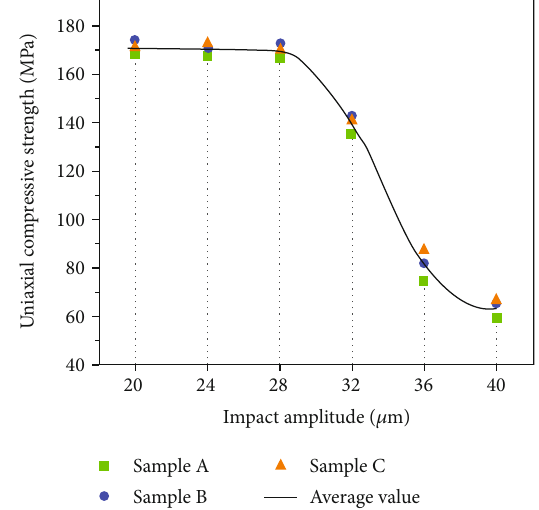
Figure 6: Uniaxial compressive strength of granite specimens under 120 seconds of UHF impact with di ff erent